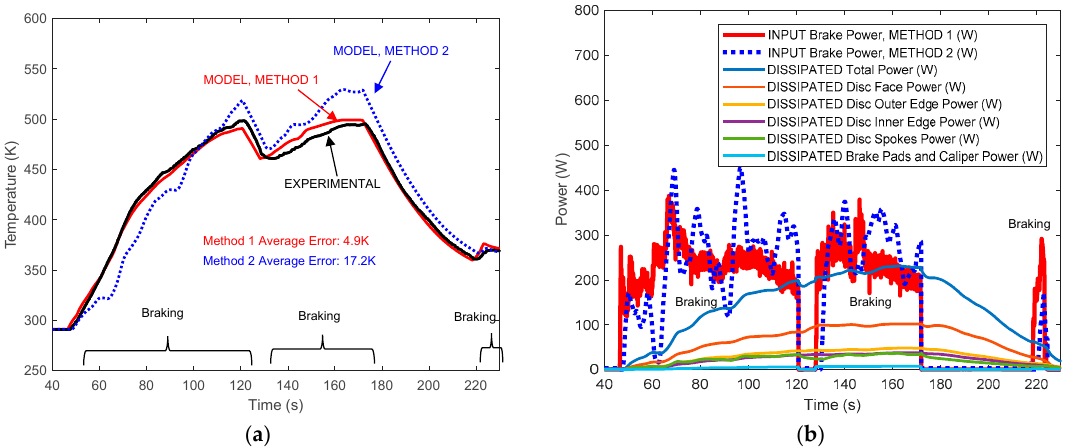
Figure 3. ( a ) Transient numerical modeling results from a downhill test showing temperature history for several braking events, with models shown for braking power determined via Method 1 (pressure, speed, and friction data) and via Method 2 (speed and elevation data), and compared to experimental data with total average errors indicated (cid:1516)(cid:3435)(cid:3627)𝑇 (cid:3040)(cid:3042)(cid:3031)(cid:3032)(cid:3039) − 𝑇 (cid:3032)(cid:3051)(cid:3043)(cid:3032)(cid:3045)(cid:3036)(cid:3040)(cid:3032)(cid:3041)(cid:3047) (cid:3627)(cid:3439)𝑑𝑡/𝑡 (cid:3047)(cid:3042)(cid:3047)(cid:3028)(cid:3039) ; ( b ) Input brake power for Methods 1 and 2, and example capability of the model to predict dissipated power for different disc surfaces (dissipated power is shown only for Method